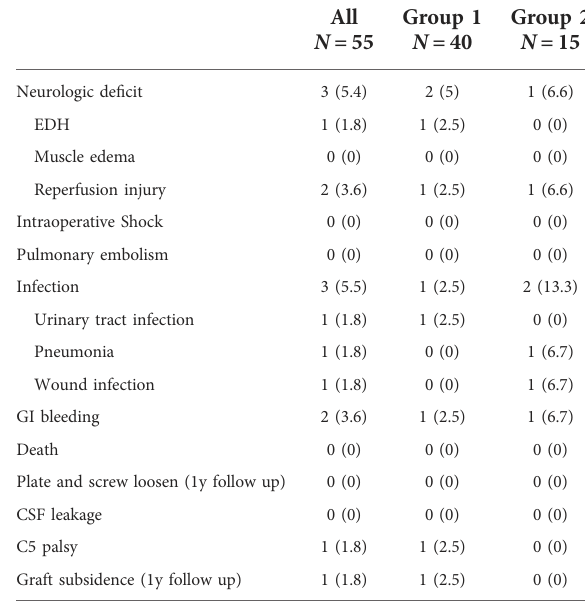
Group 1: laminectomy and then ADF, Group 2: laminectomy and PDF. EDH, epidural hematoma; GI bleeding, gastrointestinal bleeding; CSF, cerebrospinal fl